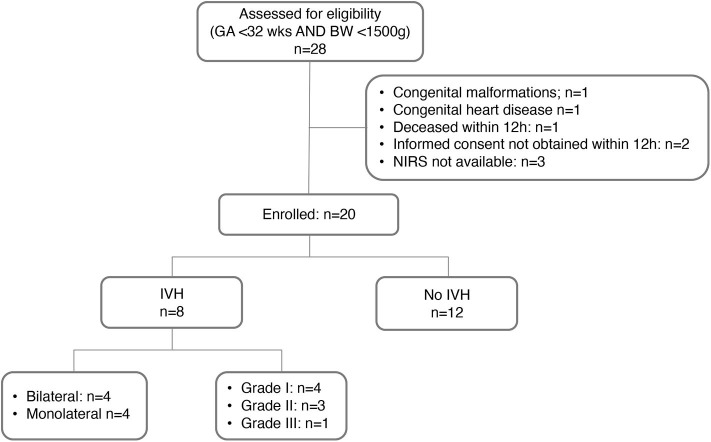
Flow-chart of the study phases. GA, gestational age; BW, birth weight; NIRS, near-infrared spectroscopy; IVH, intraventricular hemorrhage.